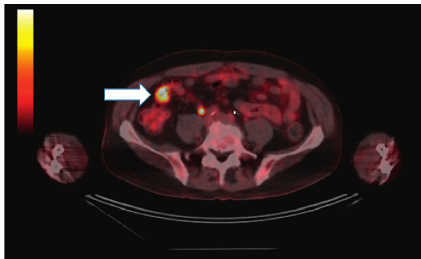
Figure 1: PET (positron emission tomography) scan with persistent and increasing FDG uptake in distal small bowel (arrow).